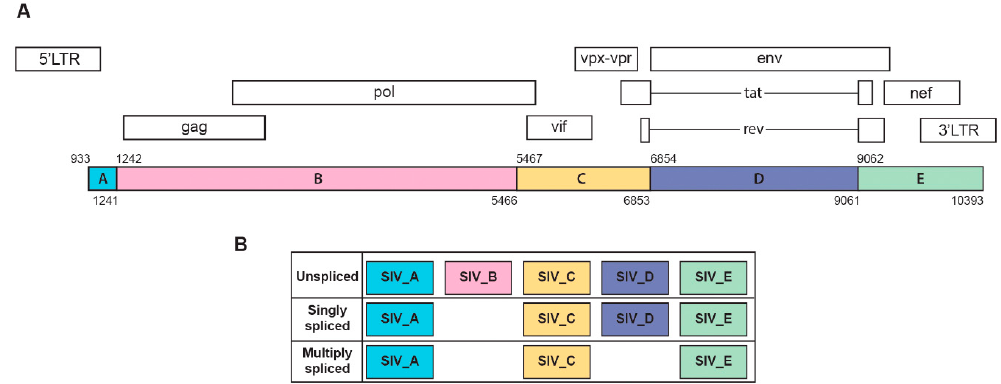
Figure 3. UMAP plots after removal of clusters containing CTL/NK and endothelial cells. ( A ) Graph- based clusters are designated by different colors. ( B ) Cells from the two conditions are designated by different colors. ( C ) Only cells that contained RNA transcripts from SIV are shown.